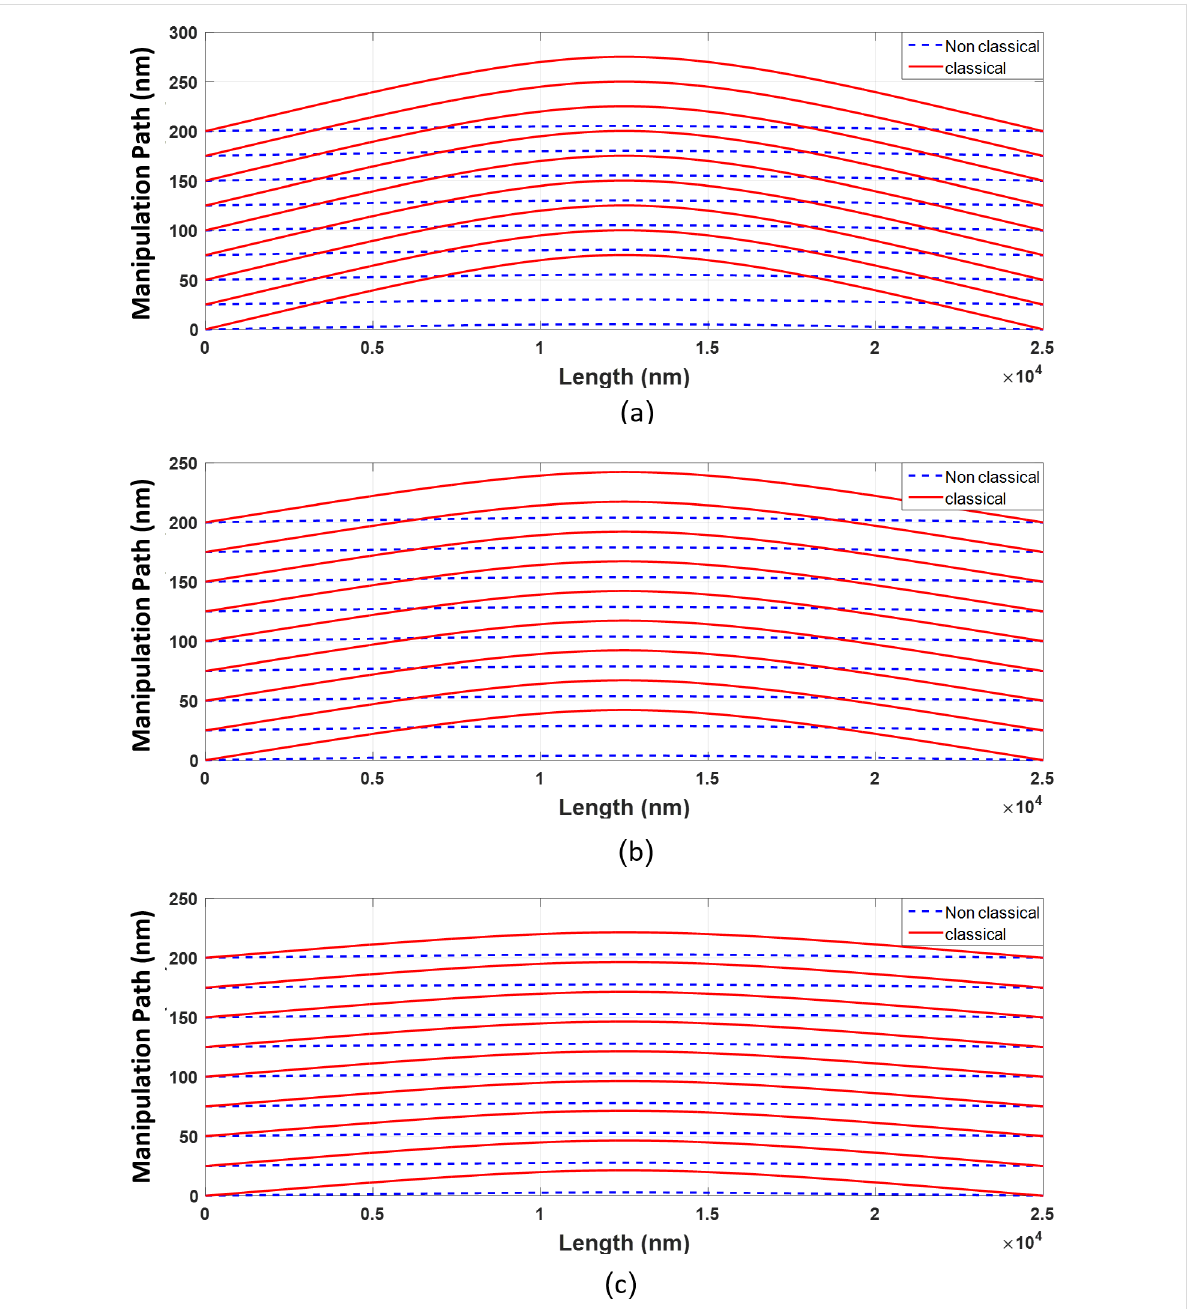
Figure 11: Simulation of motion of a cylindrical gold nanoparticle during a manipulation of 200 nm. A) Aspect ratio of 35. B) Aspect ratio of 30. C) Aspect ratio of